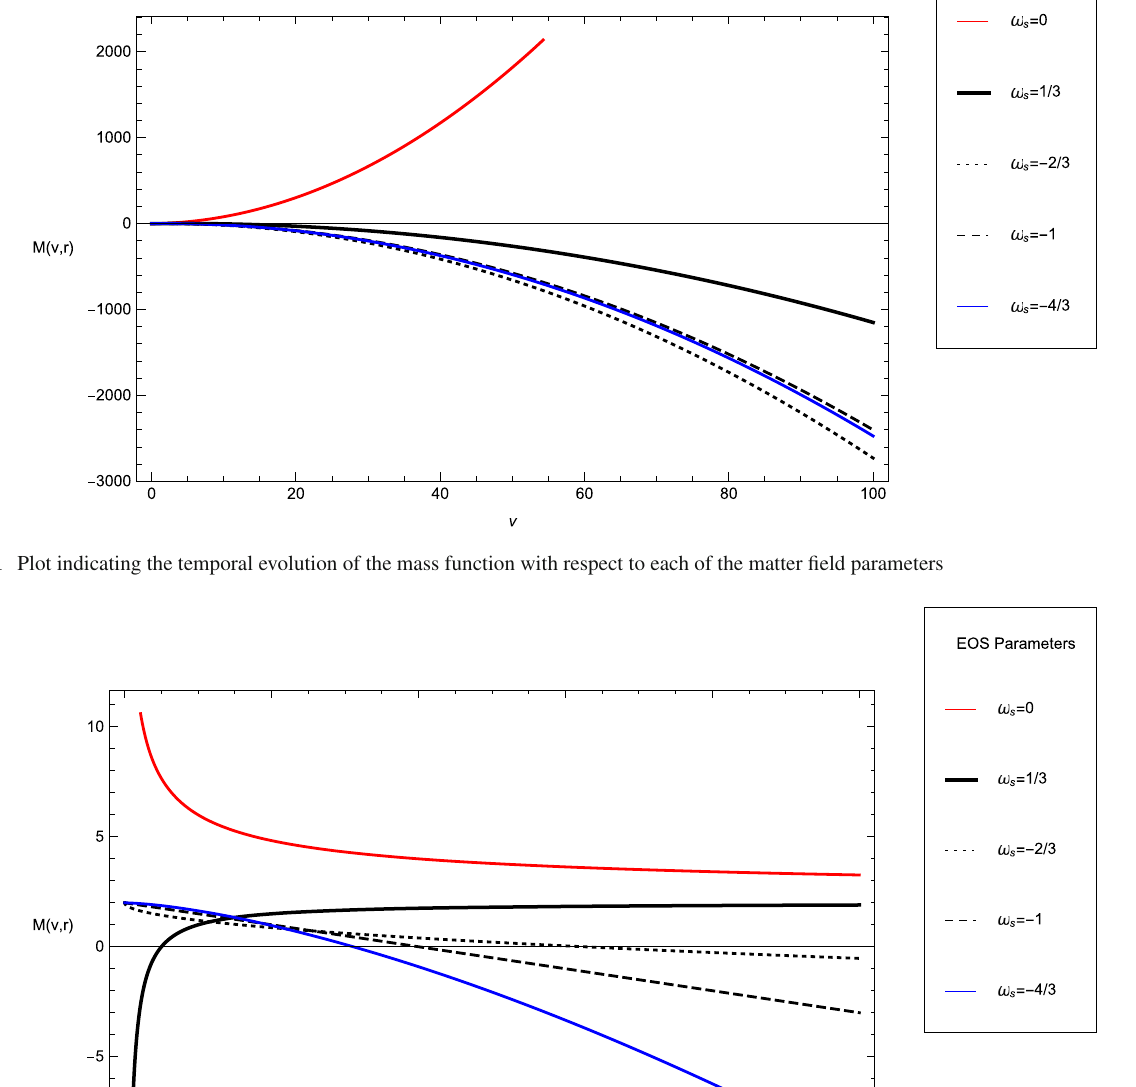
rate than for the ω s = − 2 and cosmological constant-like 3 ( ω s = − 1) cases, initially. However, it soon causes the mass function to decrease significantly faster than those two